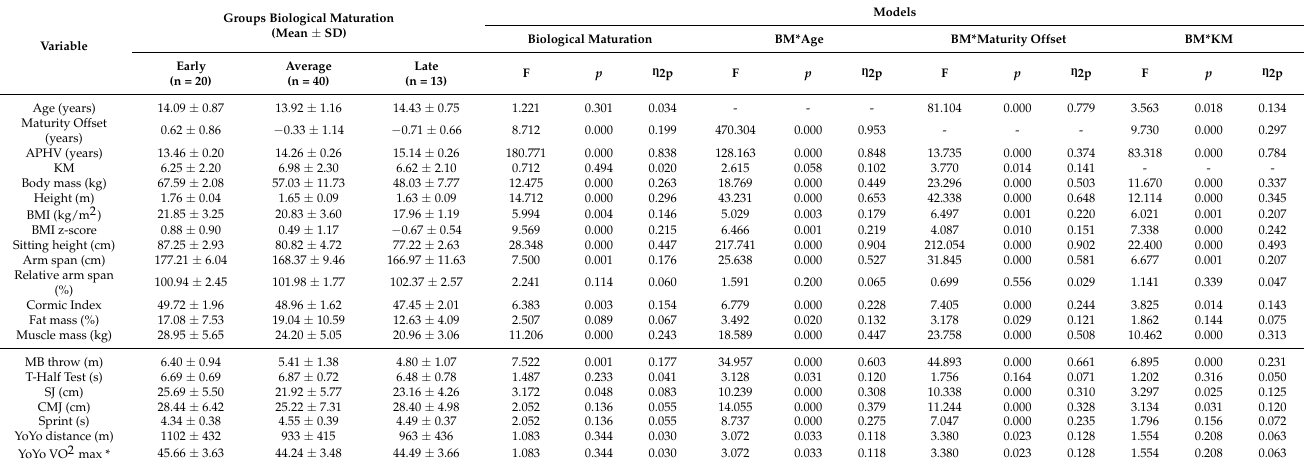
Table 1. Descriptive data and differences according to biological maturation group, including the effects of the covariates age, maturity offset and KM score.